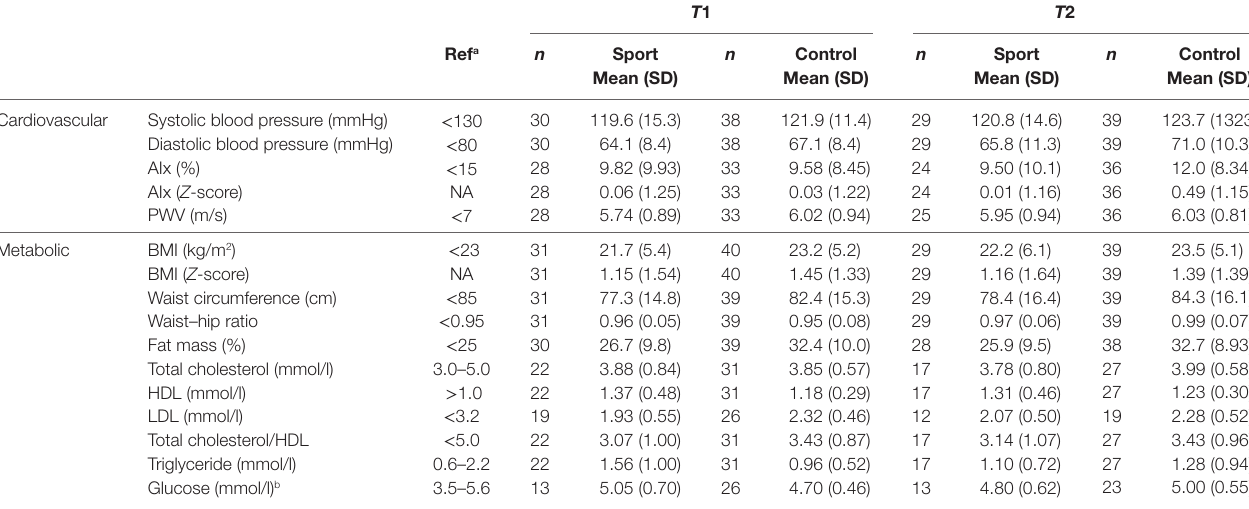
TaBlE 3 | Mean (SD) of cardiometabolic health before ( T 1) and after ( T 2) the school-based sports program.